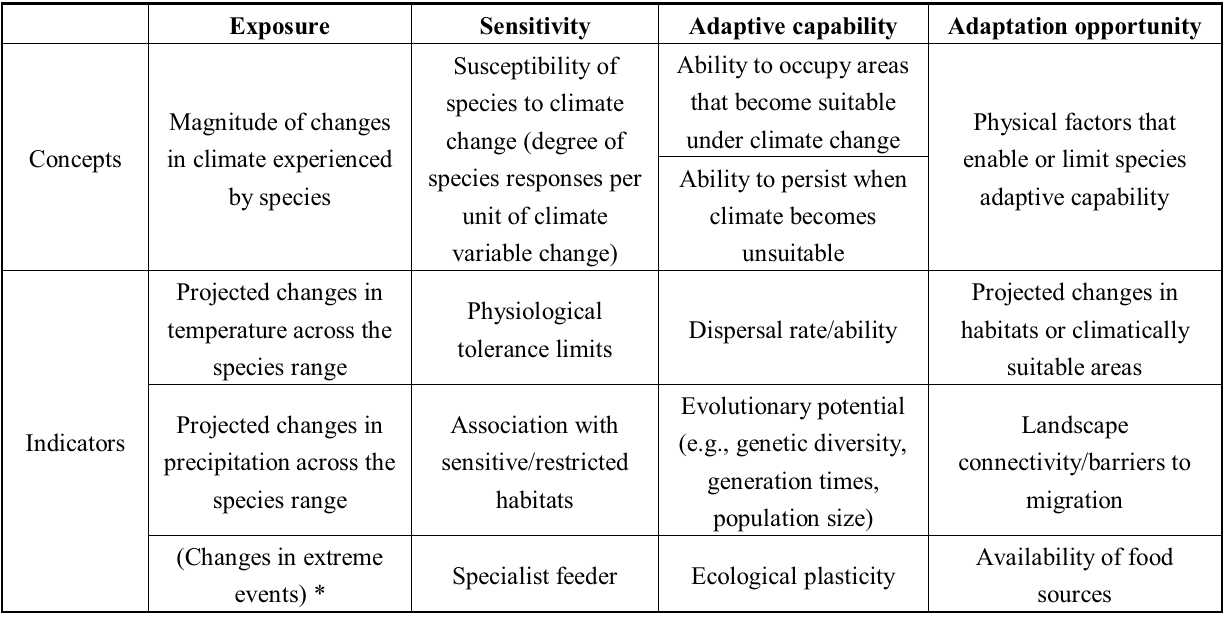
Table 1. The components of the vulnerability assessment for threatened